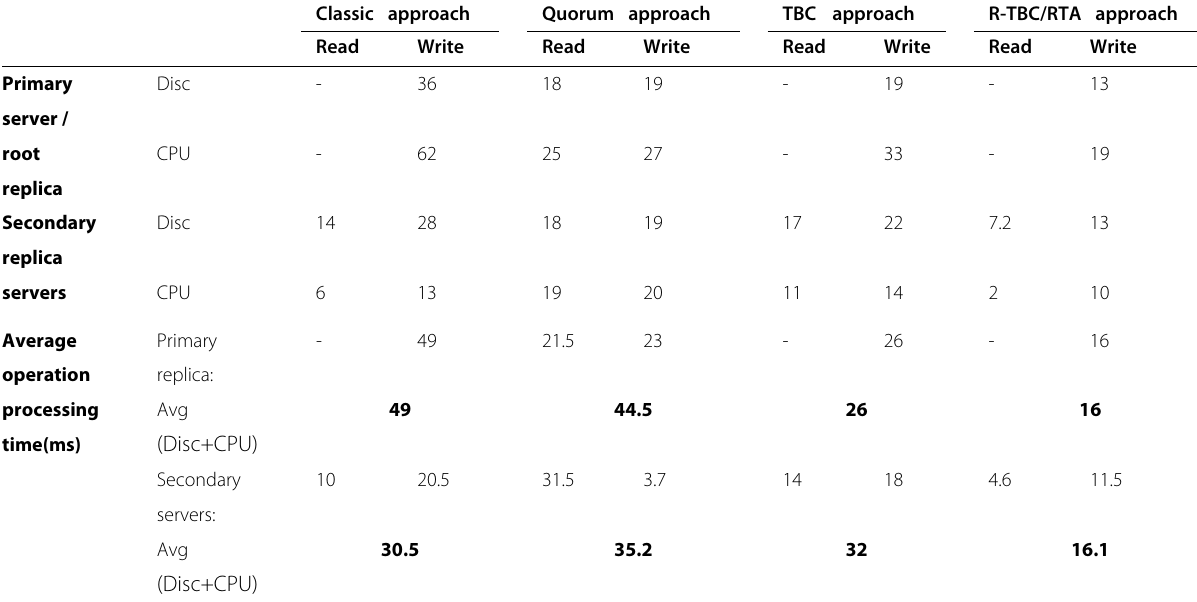
Table 4 The processing times (ms) of read/write operations (50/50 R/W ratio) for standard approaches (Classic, Quorum, TBC) and proposed advanced R-TBC/RTA approach for maintaining the consistency of the cloud DBMS Classic